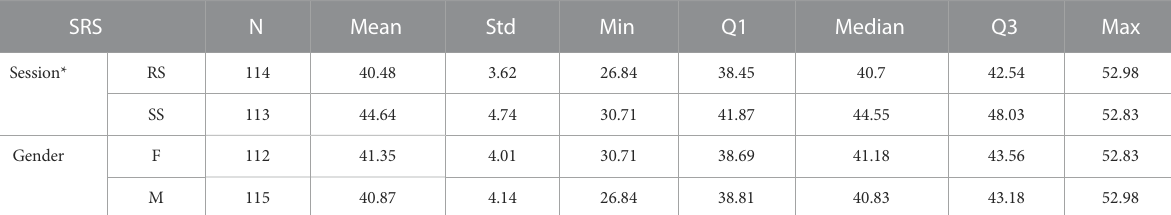
TABLE 11 Physiological Stress Model